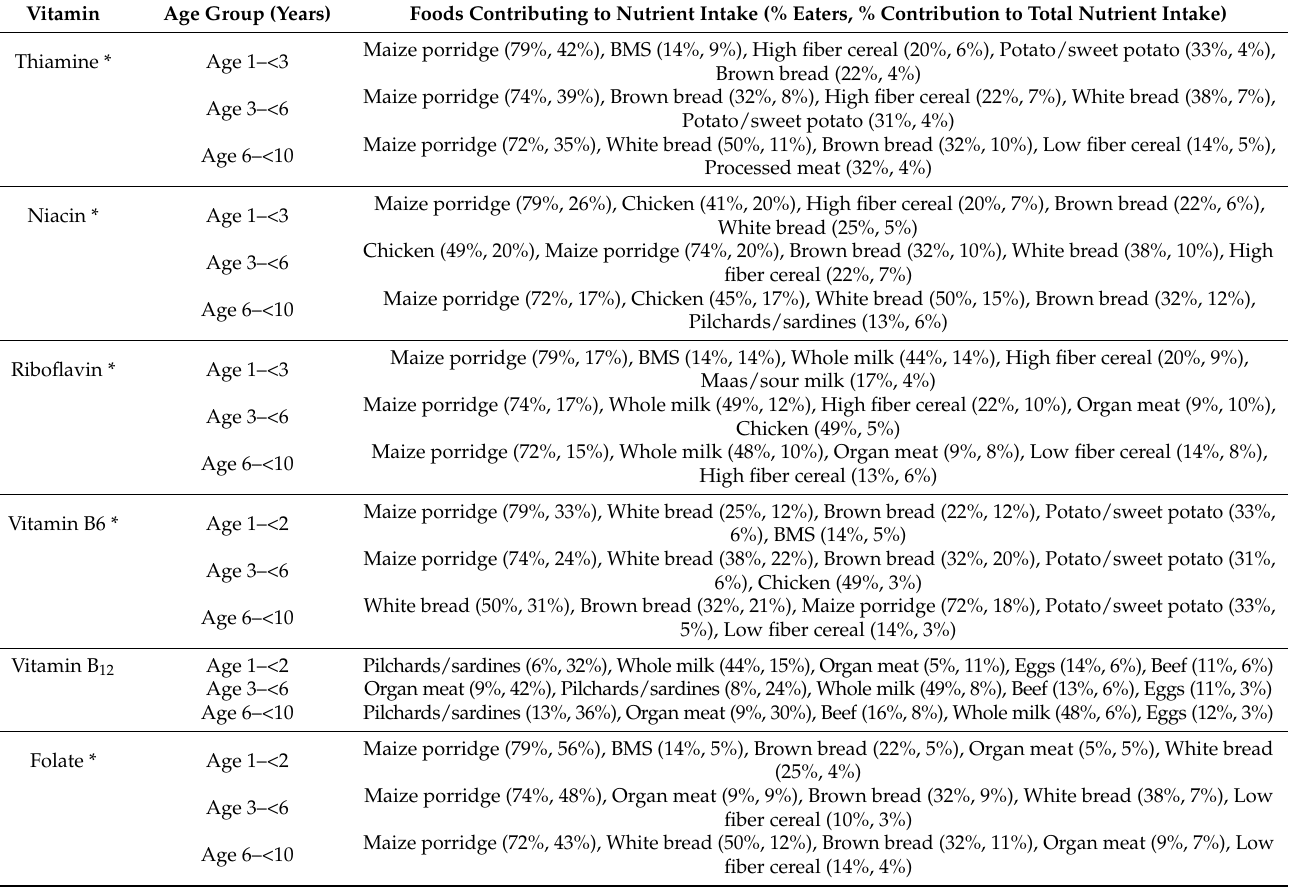
Table 12. Top 5 food items that contributed to thiamine, niacin, riboflavin, vitamin B6, vitamin B12 and folate intakes, by age group (Day-1